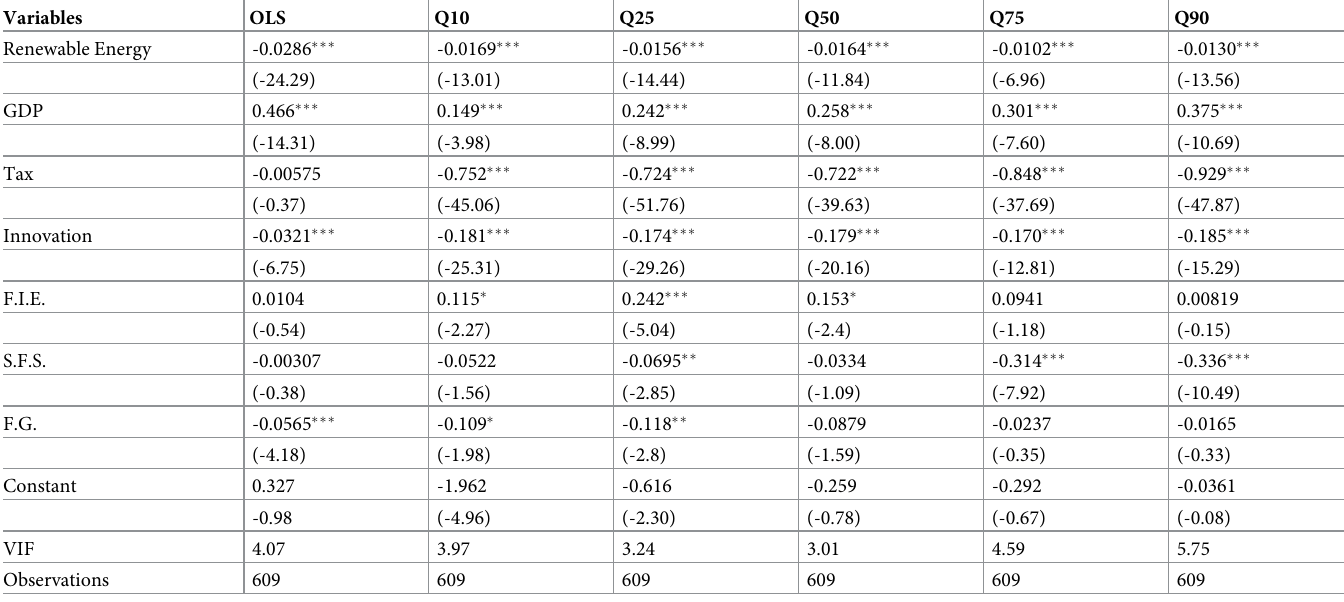
Table 6. Quantile regression extended in a quantile